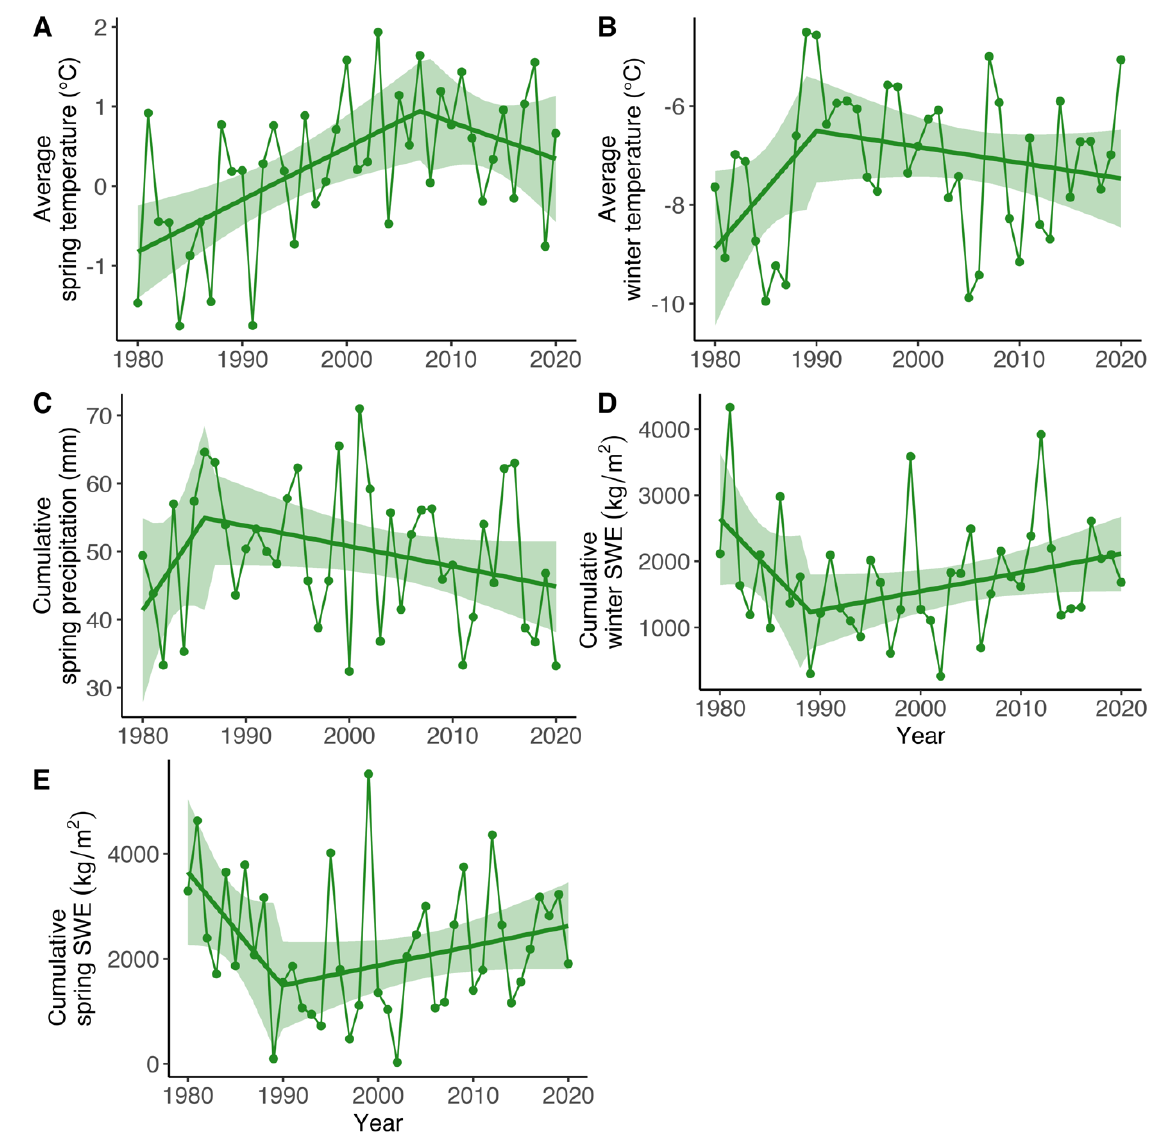
Figure 2. Trends over the study period of the five focal environmental variables. (A) Average minimum daily temperature in spring. The piecewise regression identified the year 2007 (± 9, 95% CI) as a breakpoint. (B) Average minimum daily temperature in winter. The year 1990 (± 7, 95% CI) was a breakpoint. (C) Cumulative precipitation in spring. The year 1986 (± 8, 95% CI) was a breakpoint. (D) Cumulative snow water equivalent (SWE) in winter. The year 1989 (± 7, 95% CI) was a breakpoint. (E) Cumulative SWE in Spring. The year 1990 (± 7, 95% CI) was a breakpoint. In all plots green ribbons represent the 95% CI for the linear regressions. Table S4 in the Appendix shows the summary of these five piecewise